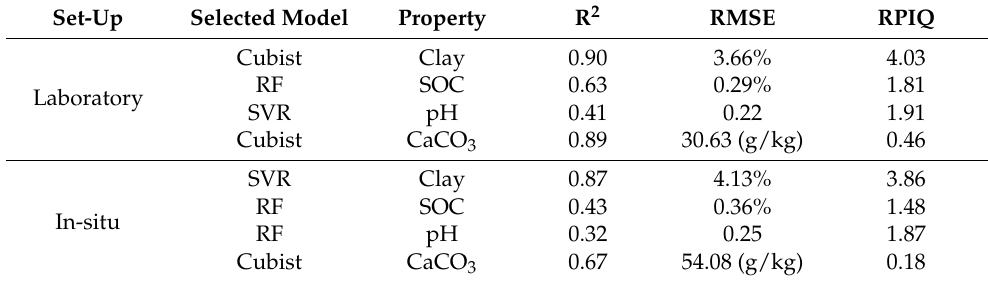
Figure 13. Scatterplots of the observed predicted values of the soil properties for the laboratory ( upper ) and in-situ ( lower ) modelling cases (best fitting line and 95% confidence interval). Table 3. Accuracy metrics for the best fitting model per property and experimental